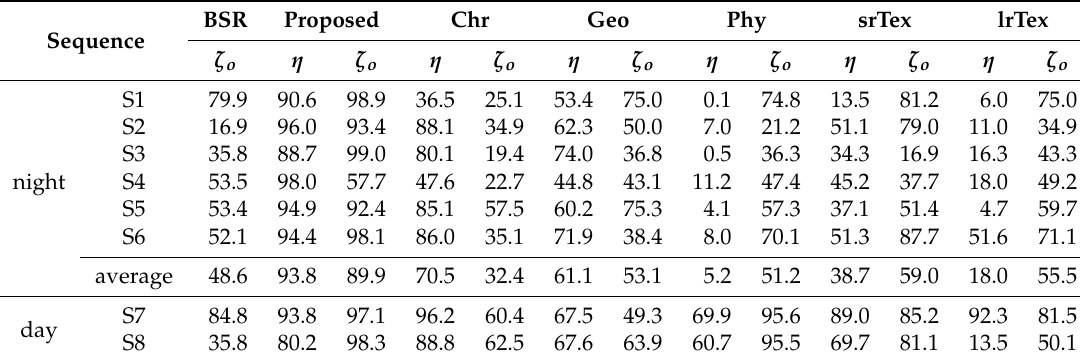
Table 2. Performance comparison in pixel and object